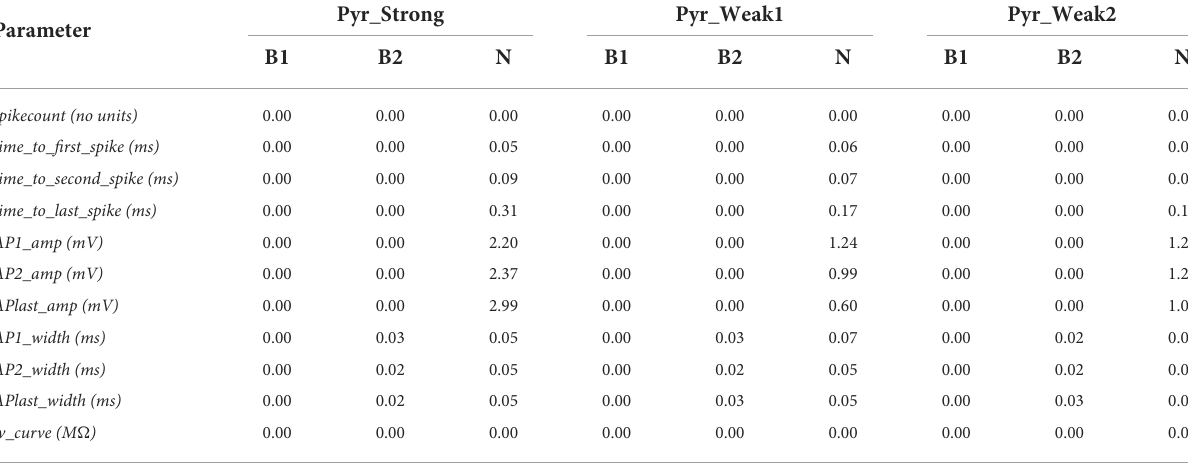
TABLE 3 Root mean squared error (RMSE) values quantifying the match between the reproduced models for various electrophysiological features. Parameter